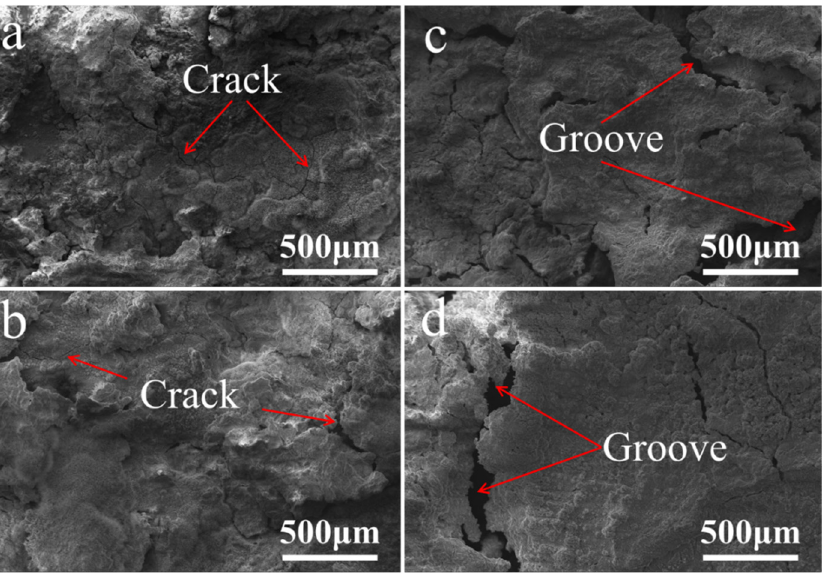
Figure 5. The morphologies of discharge products on IC33 alloy during discharging in 3.5% NaCl solution at different current densities: ( a ) as-cast, 2.5 mA cm − 2 ; ( b ) extruded, 2.5 mA cm − 2 ; ( c ) as-cast, 30 mA cm − 2 ; ( d ) extruded, 30 mA cm − 2 .